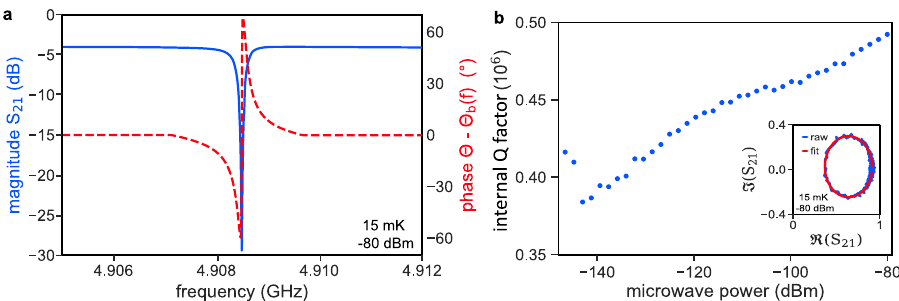
Fig. 3 Exemplary resonator response and power-dependence of the internal quality factor. a Single-tone response of a strongly overcoupled resonator similar to the microwave circuit shown in a with a sample chip attached to it and with the nanowire Josephson junction set into pinch-off. The blue line corresponds to the measured change in magnitude and the red line to the unwrapped phase, respectively. The latter has been corrected by the frequency- dependent background phase Θ b ( f ). b Extracted internal quality factor of the very same resonator as a function of the applied microwave power. Measurements are performed at T ~ 15 mK and the rf-power is indicated with the fridge-internal attenuation accounted for. The inset shows an exemplary circle fi t of the resonator in the IQ plane at an applied microwave power of − 80 dBm.